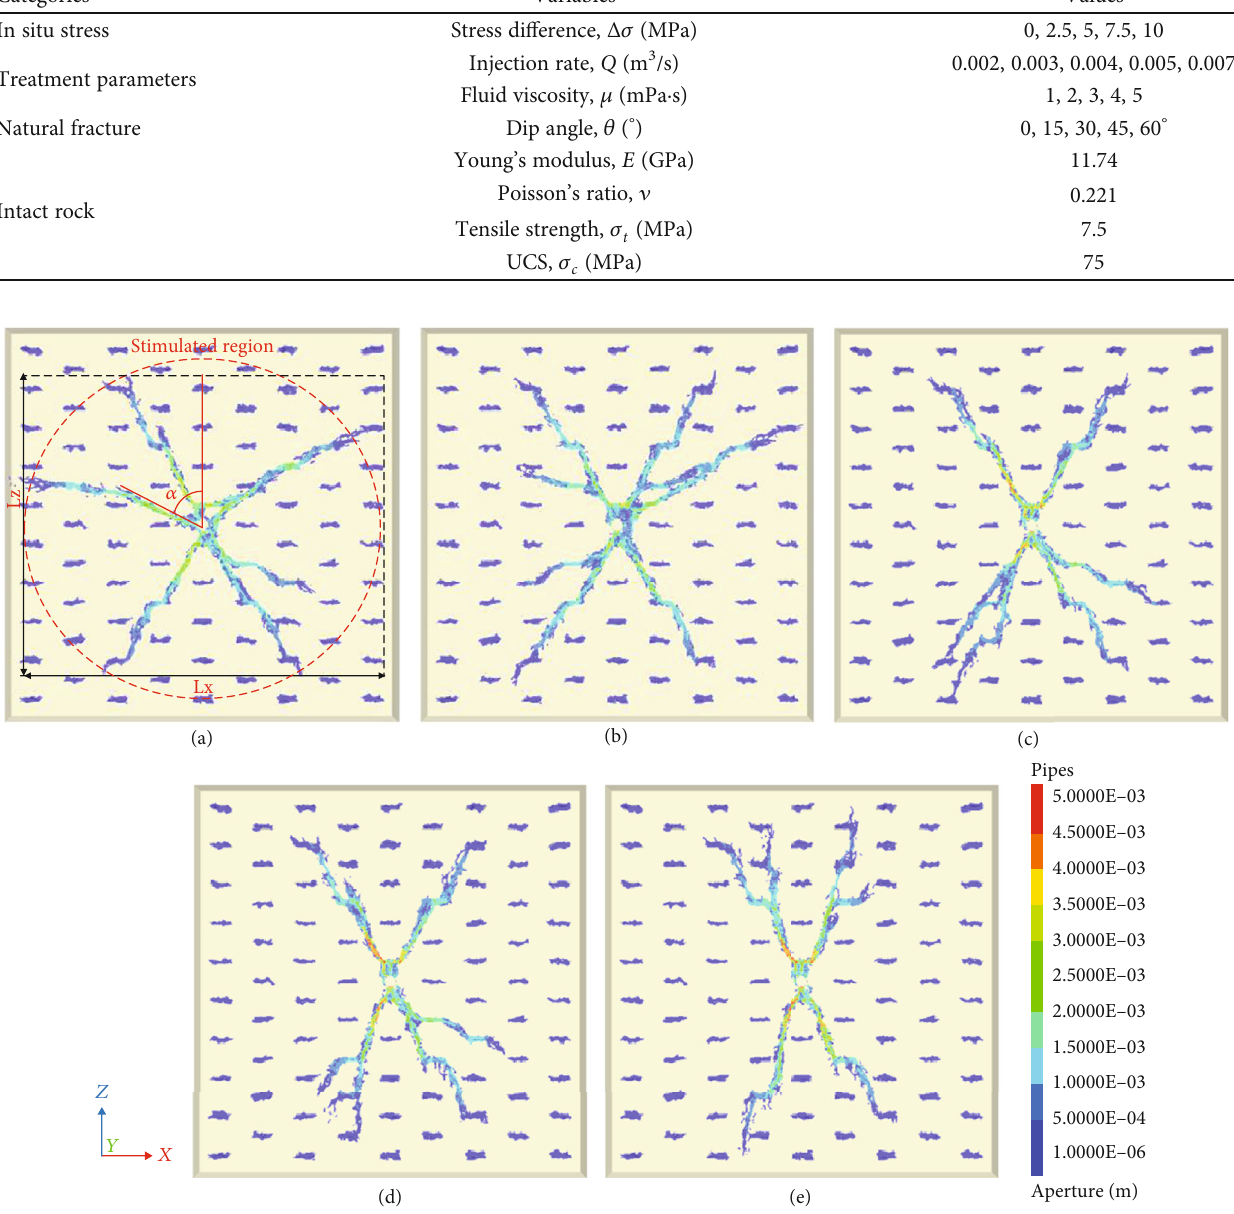
Figure 8: HF propagation in the NFN with varying stress di ff erences: (a) 0 MPa, (b) 2.5MPa, (c) 5 MPa, (d) 7.5MPa, and (e) 10